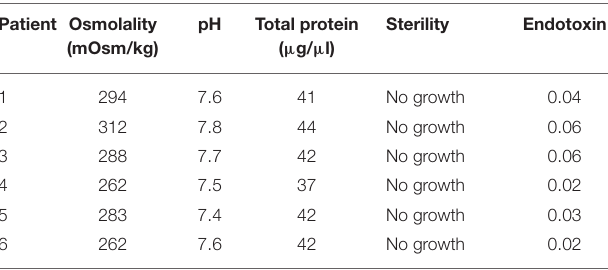
TABLE 4A | Physicochemical properties of HUF samples collected by uterine flushing of women who accepted to participate in the proof-of-concept NCT03436758QC and fulfilled all the inclusion criteria, namely, the retrieval of at least eight metaphase II oocytes and transfer of their embryos. Patient Osmolality